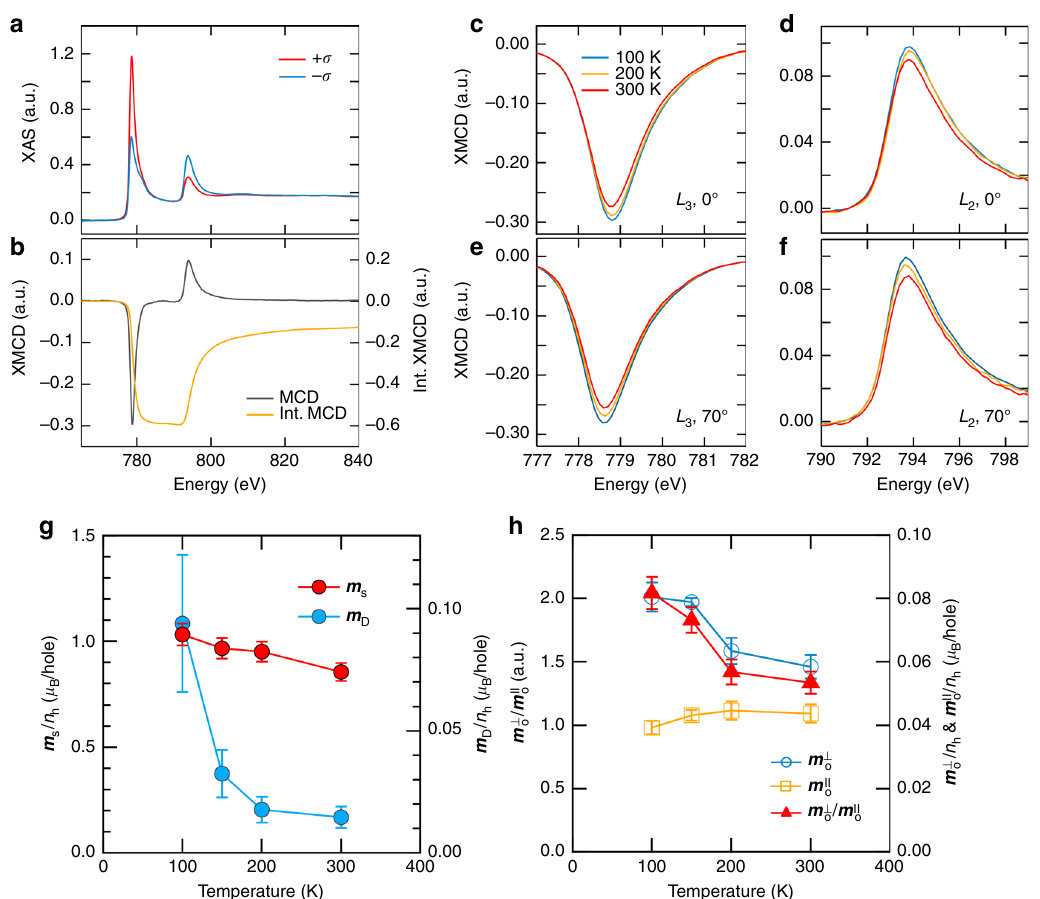
Fig. 4 Temperature dependence of the Co magnetic moments. a XAS spectra for positive ( σ + ) and negative ( σ − ) X-ray helicities. b XMCD and integrated XMCD spectra at 0° with 300 K. The temperature dependence of XMCD spectra at the Co L 3 and L 2 edges measured at ( c , d ) 0° and ( e , f ) 70°. g Plots of m m D vs temperature as a function of the X-ray incident angle. h s and standard deviation of the integral distribution after subtracting the backgrounds of XAS